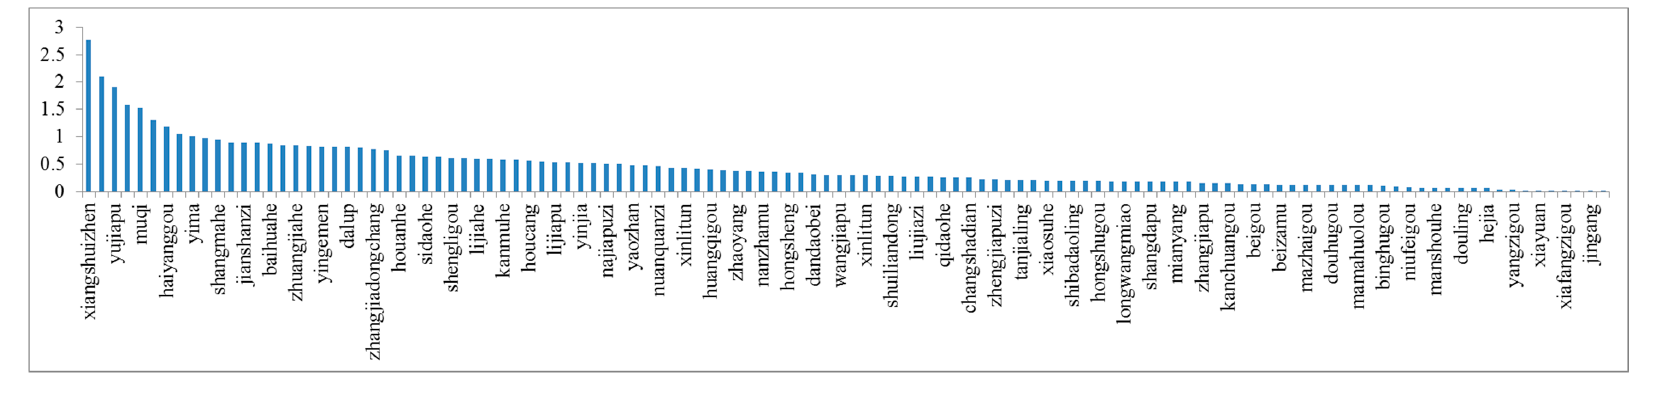
Figure 2. Comprehensive score of small watershed.